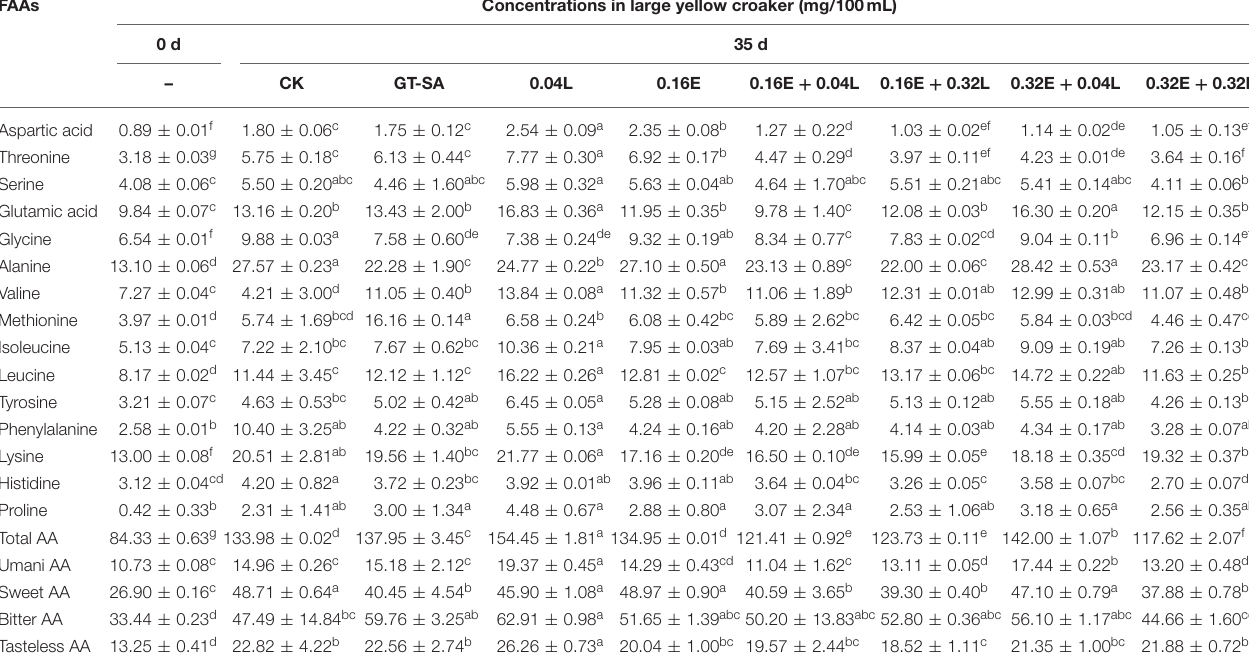
TABLE 3 | Changes in free amino acids (FAAs) of large yellow croaker samples during superchilling storage.